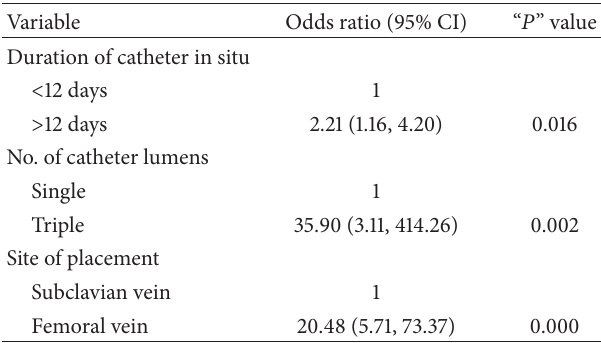
Table 4: Predisposing factors for development of catheter-related